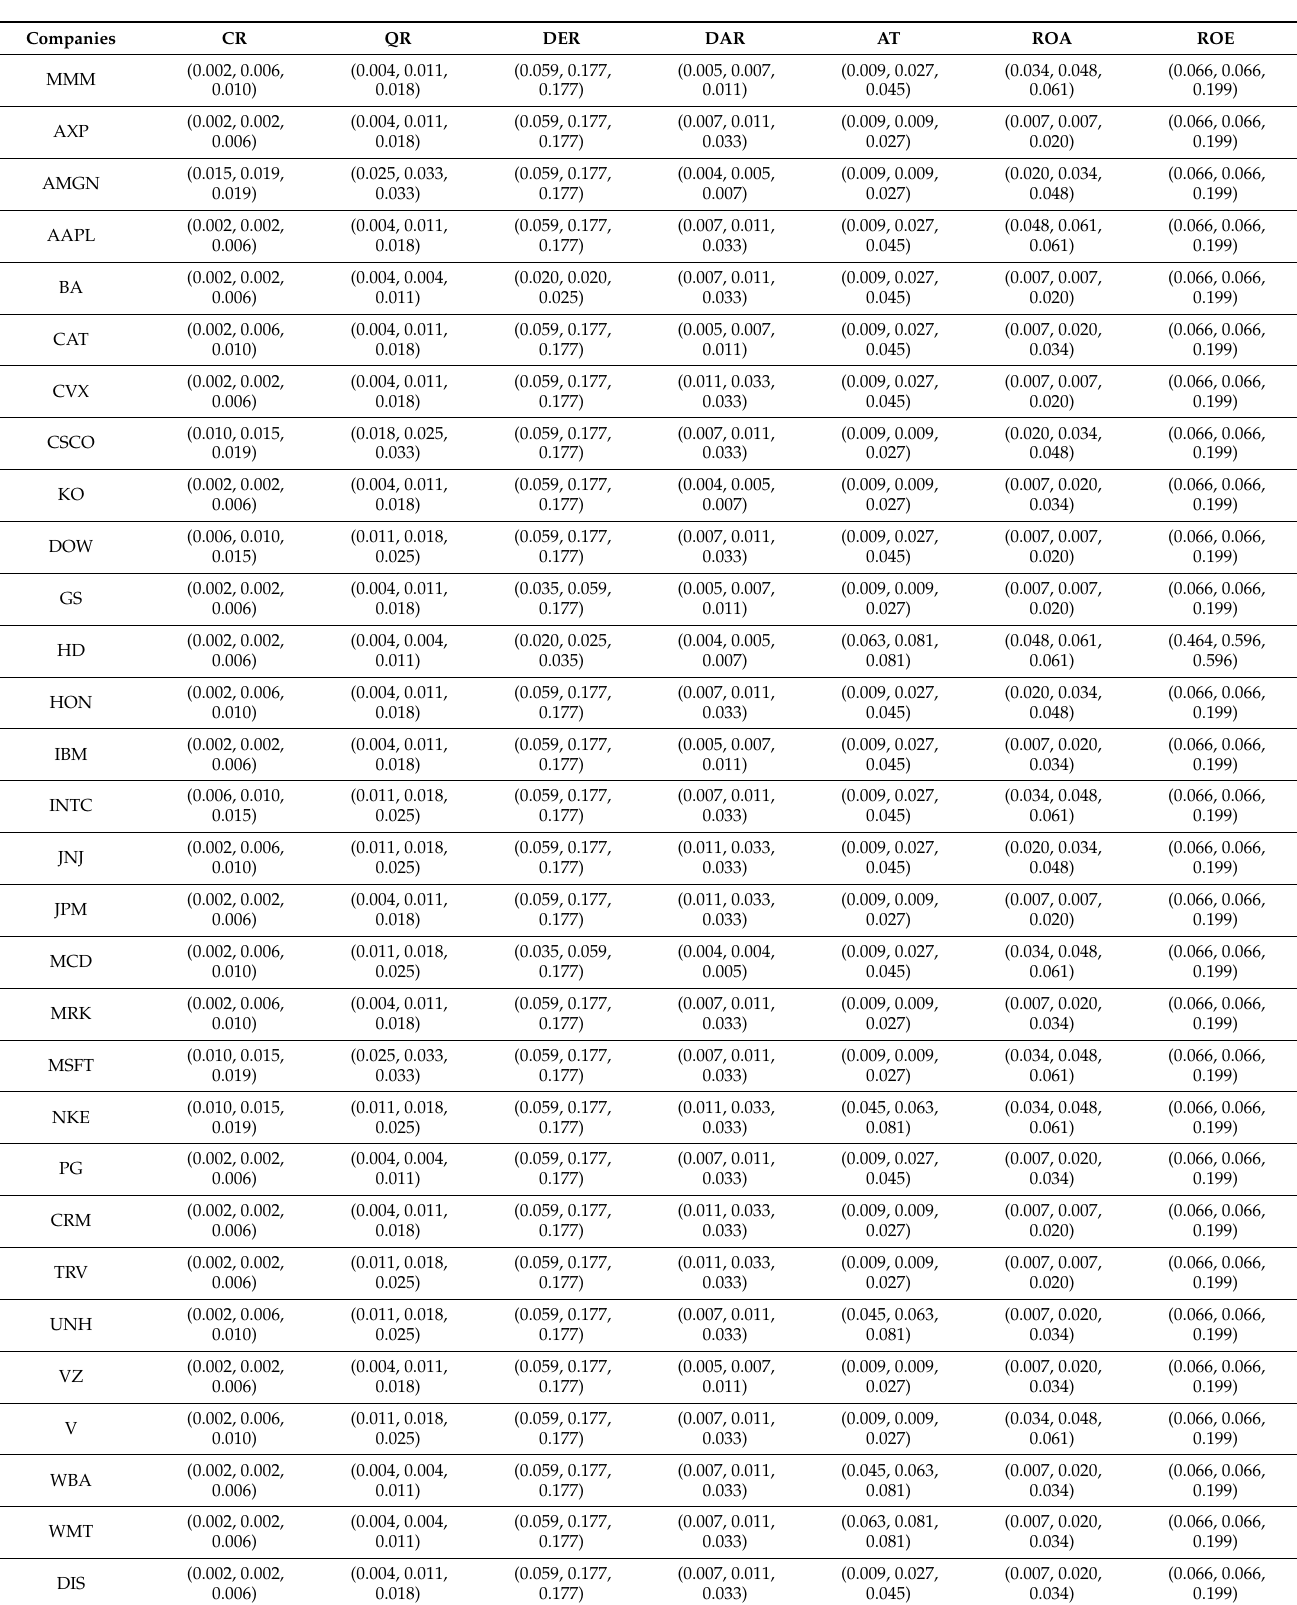
Table 7. The weighted normalized fuzzy decision matrix for the companies with respect to all financial